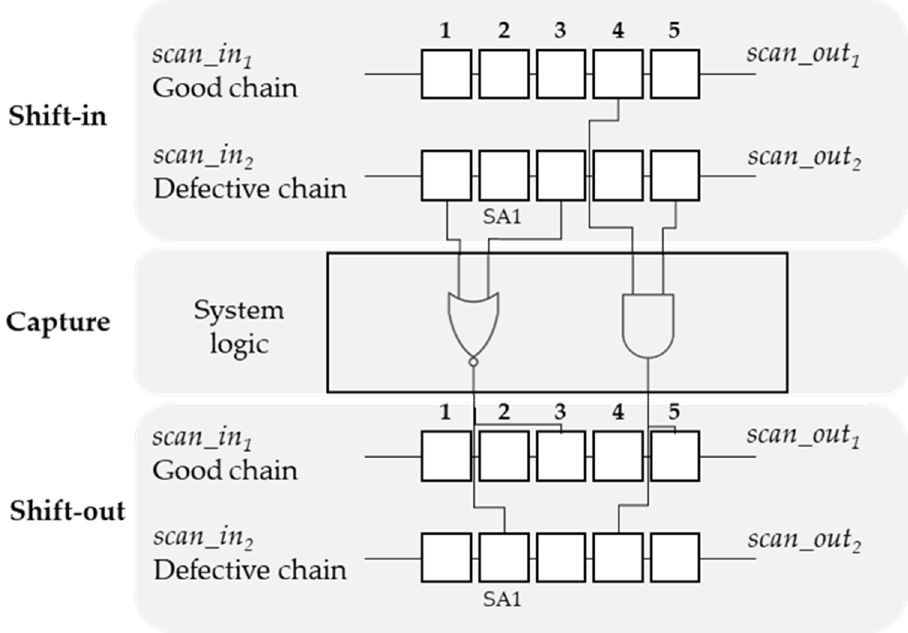
Figure 3. Sensitive cells in scan testing.